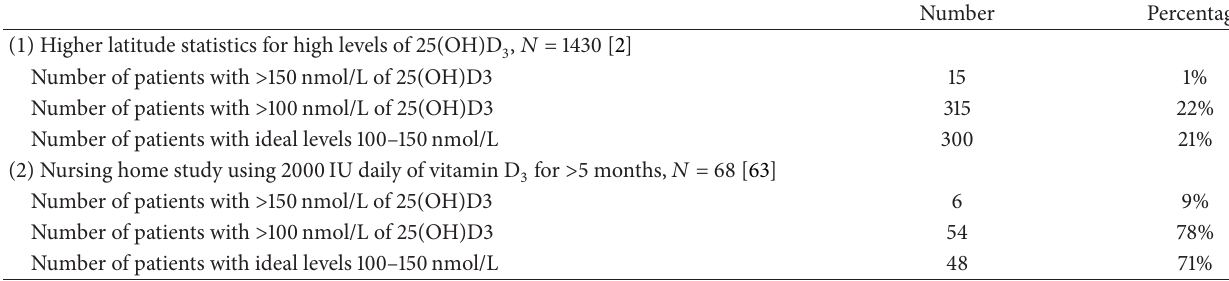
Table 2: Vitamin D levels achieved in 2 studies done at northern